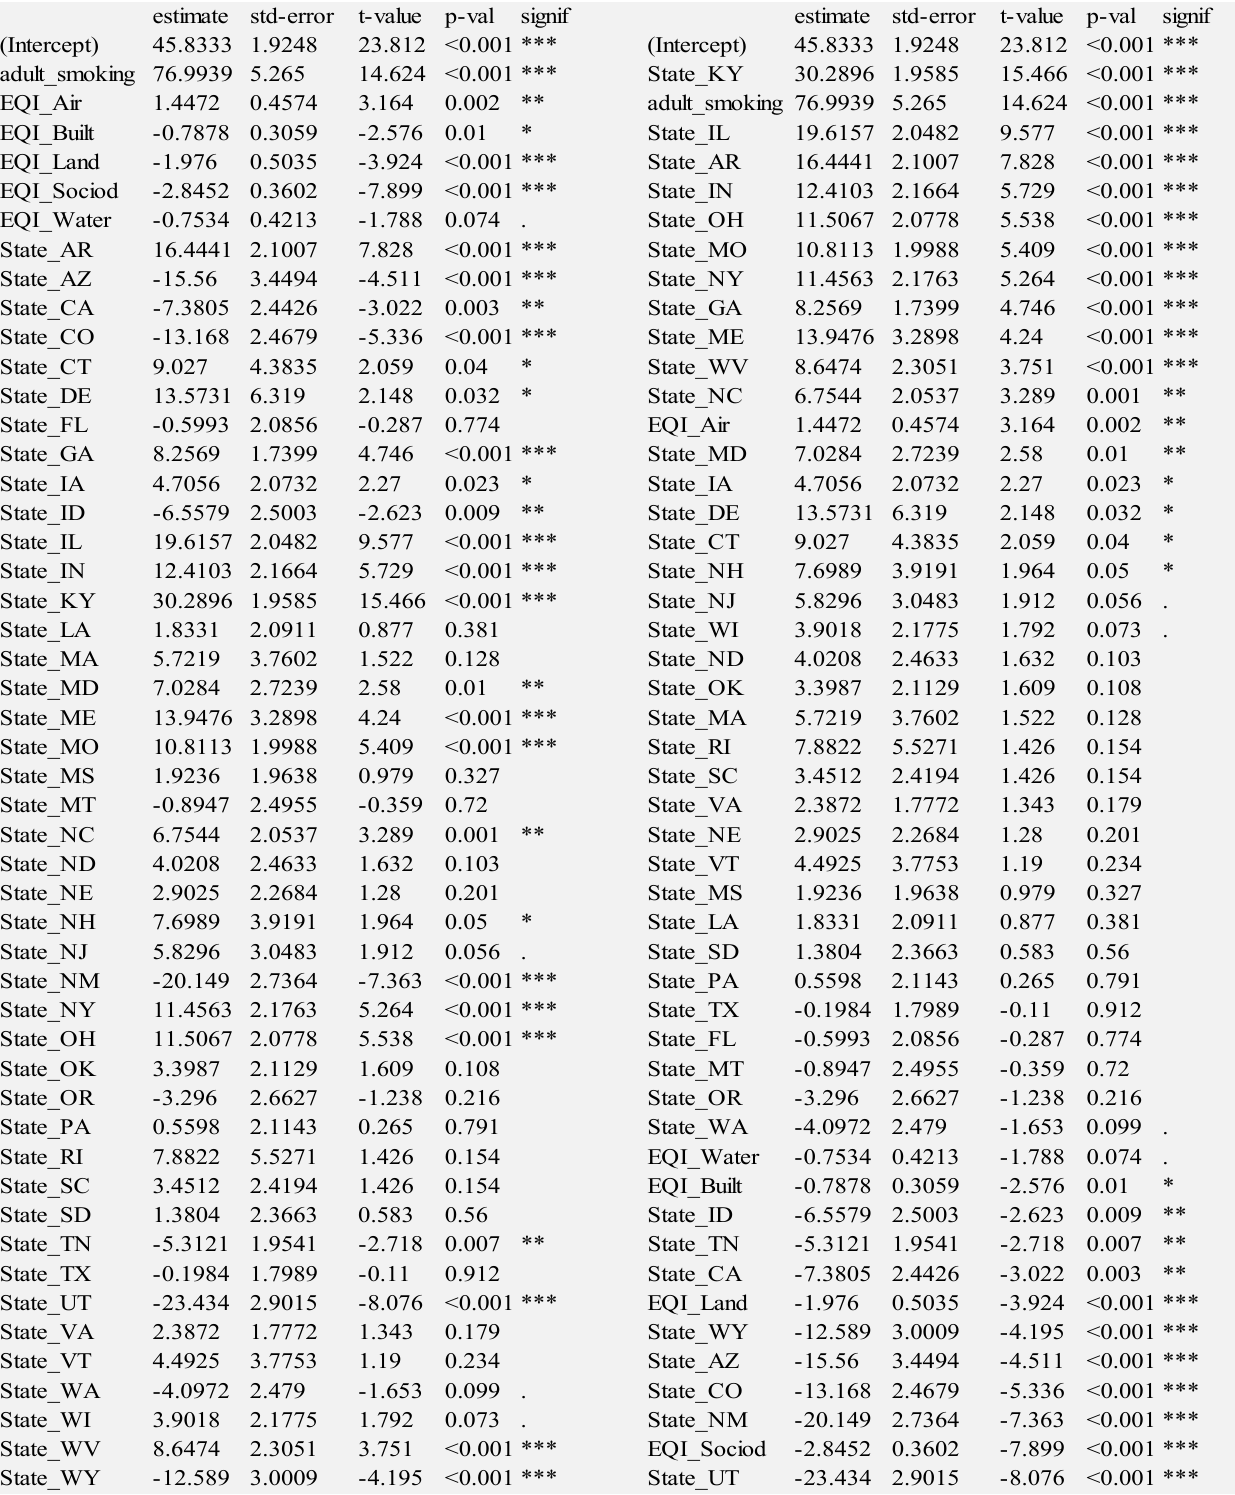
Figure 8. Foundation + Environmental Quality Index; Residual standard error: 10.5 on 2236 degrees of freedom; Multiple R-squared: 0.6197, Adjusted R-squared: 0.6114 ; F-statistic: 74.36 on 49 and 2236 DF, p -value: < 2.2 × 10 − 16 ; Significance codes: 0 ‘***’ 0.001 ‘**’ 0.01 ‘*’ 0.05 ‘.’ 0.1 ‘ ’